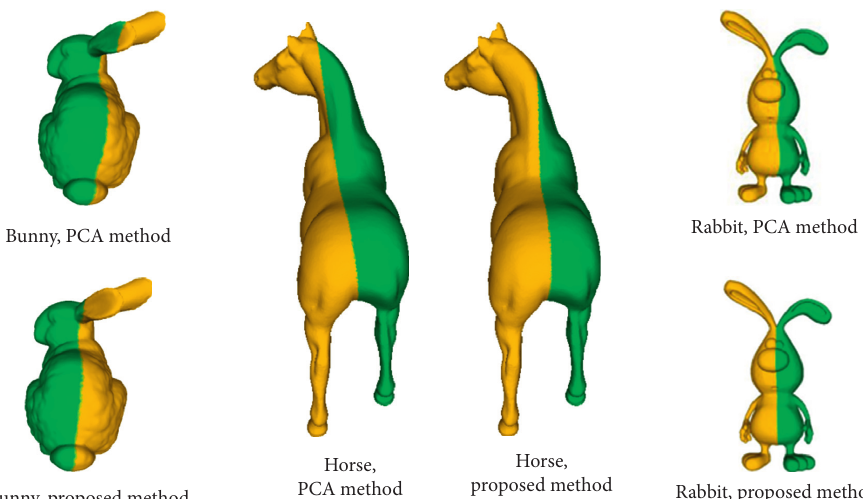
Figure 8: Comparison results of the proposed method and traditional PCA method for bunny, horse, and rabbit models. Table 1: Running time of the proposed method and PCA method.